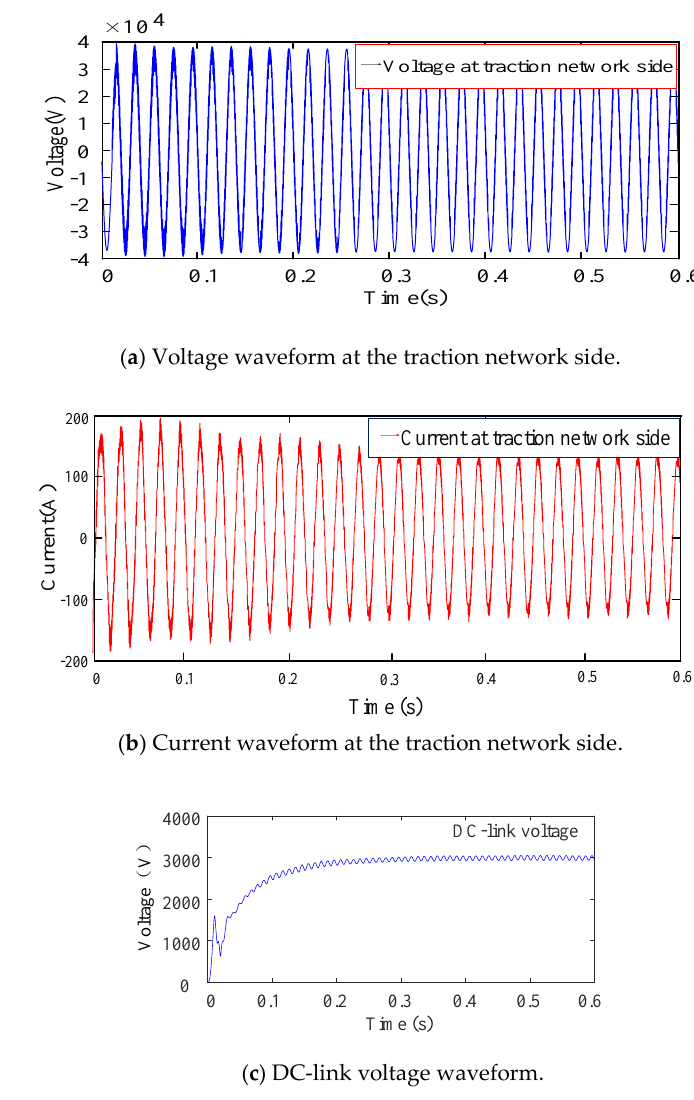
Figure 17. Voltage and current waveforms with a single EMU accessed based on the H∞ controller .